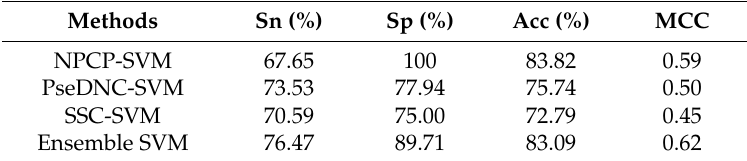
Table 1. Performances of different methods for identifying dihydrouridine (D)